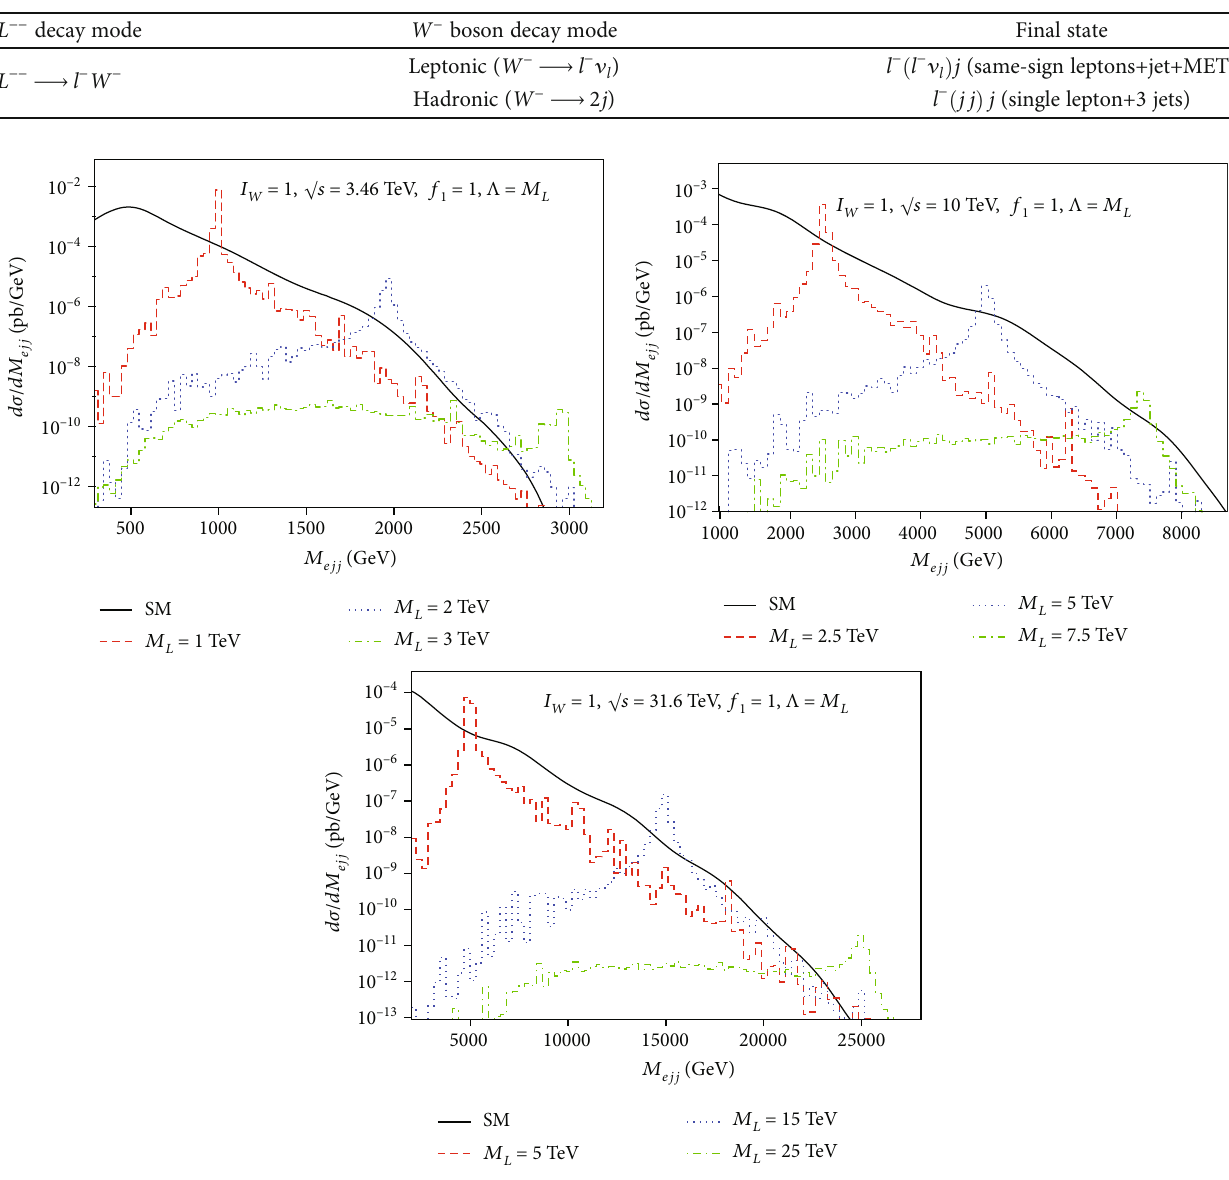
Table 3: Final states for the doubly charged lepton production at ep colliders.